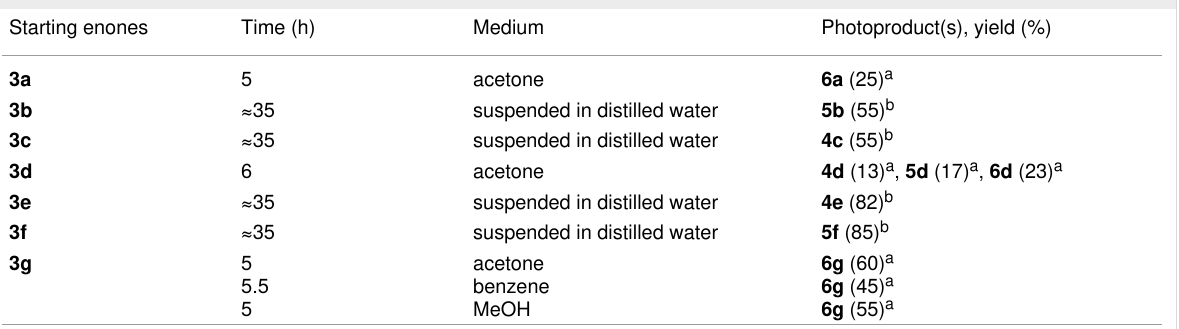
Table 1: Chemical yields of the formation of photoproducts 4 , 5 and 6 . Starting enones